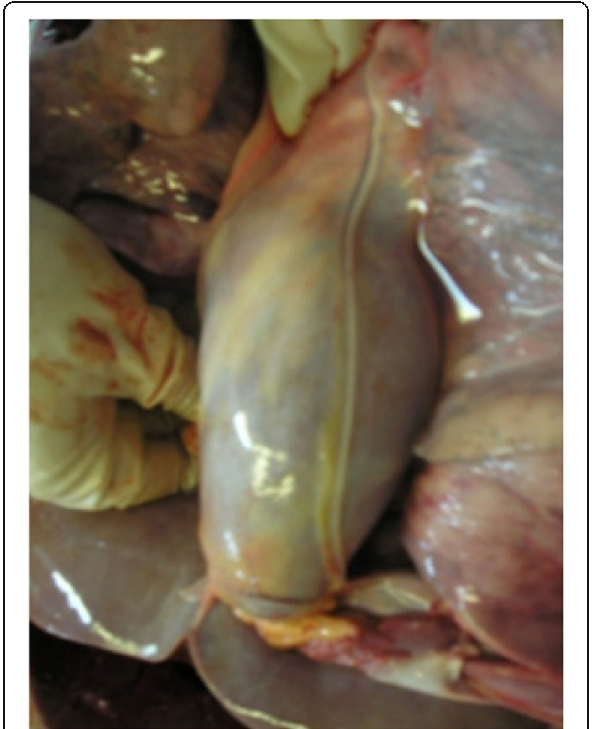
Fig. 2 ‘ Drop-like ’ heart exhibiting hypoplasia due to